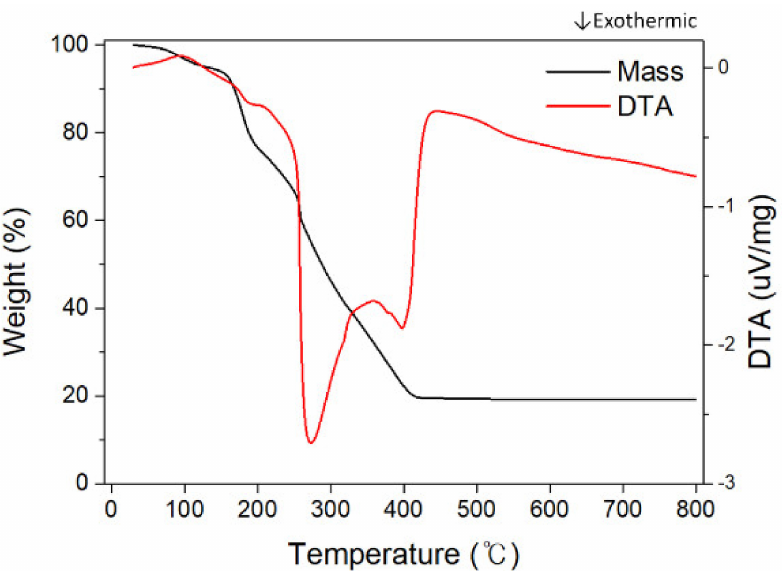
Figure 5. Thermogravimetric (TGA) curve of as-spun nanofibers obtained from precursor solution 15-B.